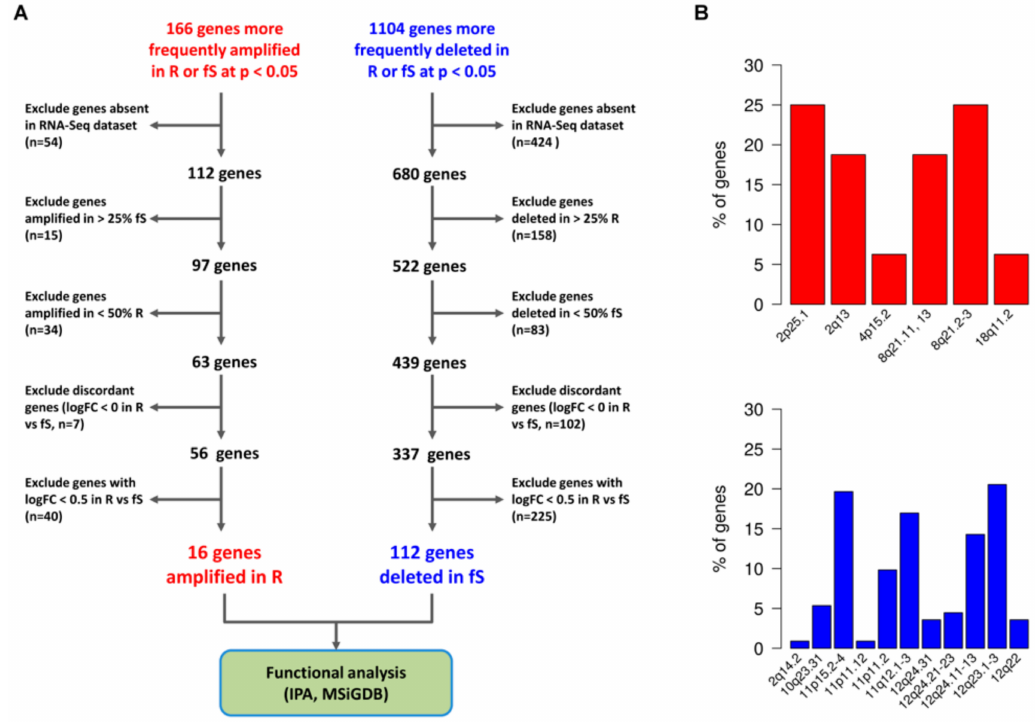
Figure 5. Association between sCNA and altered gene expression in Pt-sensitivity classes. ( A ) Selection of significant focal sCNA with concordant alteration of gene expression. Gene expression was assessed by RNA-sequencing (RNASeq) data, and for each altered gene, the logFC expression ratio of R vs fS patients was calculated. The workflow guiding selection of both amplified and deleted genes with concordant expression is shown. ( B ) Cytobands associated with significant sCNA and altered gene expression. In the plot are reported the cytobands a ff ected by significant amplification (upper panel, red bars) and deletions (lower panel, blue bars). For each type of alteration, the relative frequency of each cytoband a ff ected is